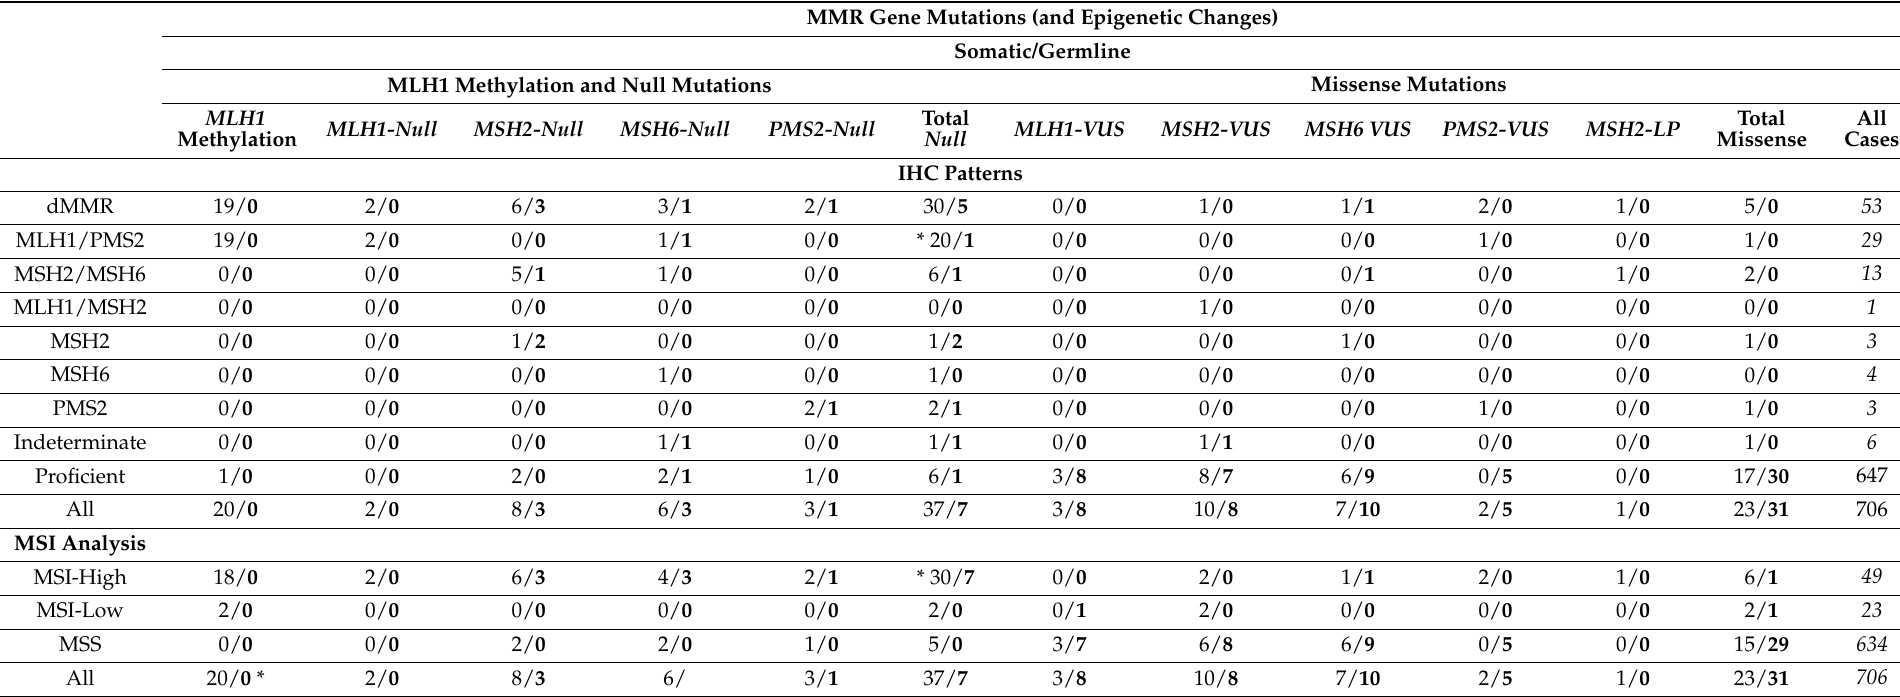
Table 4. Distribution of genetic/epigenetic aberrations according to IHC pattern and MSI analysis status. MMR Gene Mutations (and Epigenetic